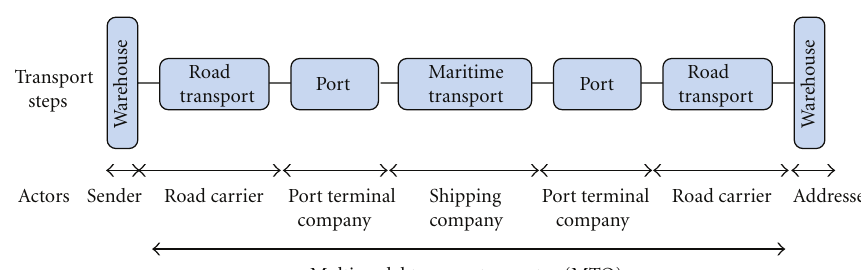
Figure 5: Actors involved in a multimodal transport